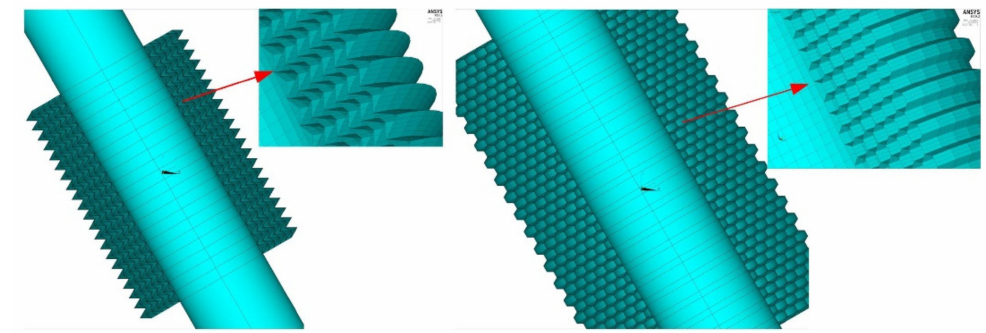
Figure 9. Cross-section view of the hexagonal honeycomb and arrow honeycomb reinforced